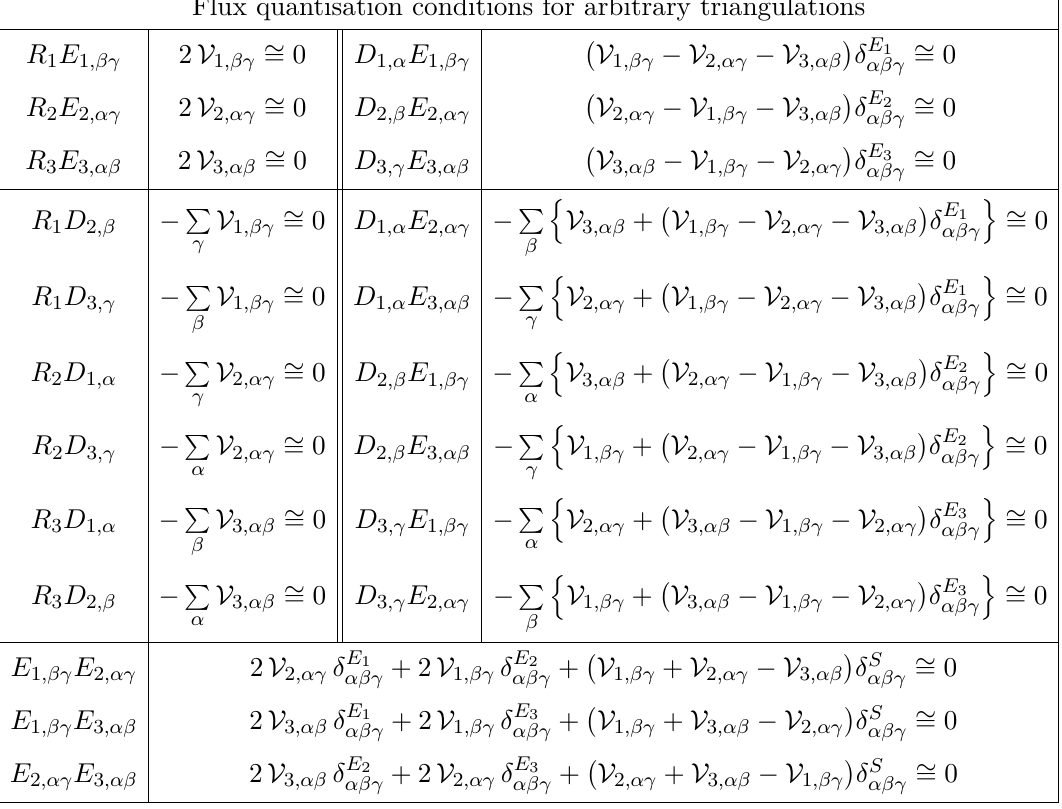
Table 2 . The flux quantisation conditions on the line bundle vectors V i,µν the resolved orbifold X using arbitrary triangulation at the 64 C 3 / Z 2 × Z 2